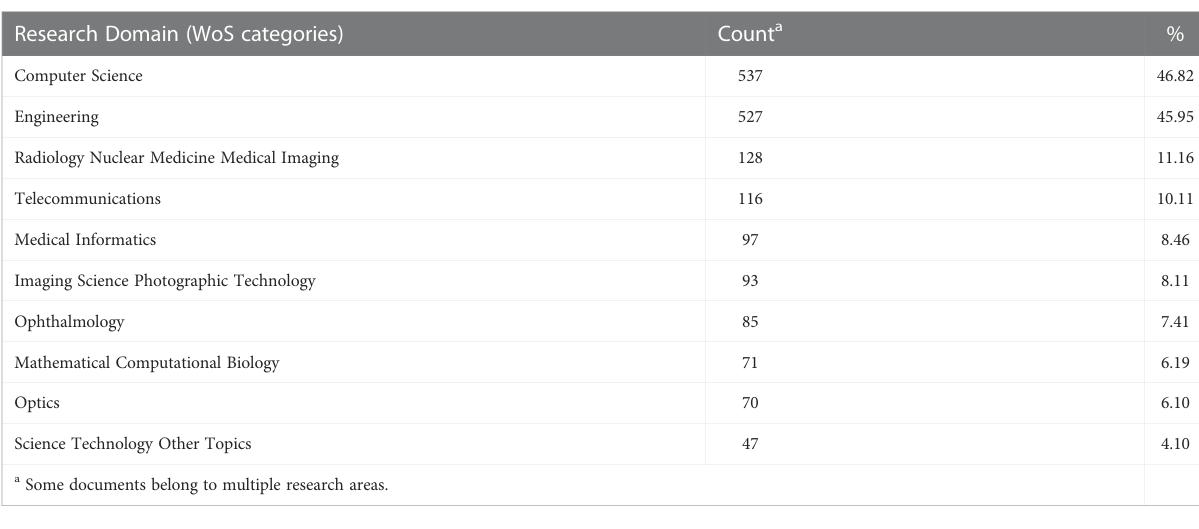
TABLE 5 The most related research domains ranked by publication count.